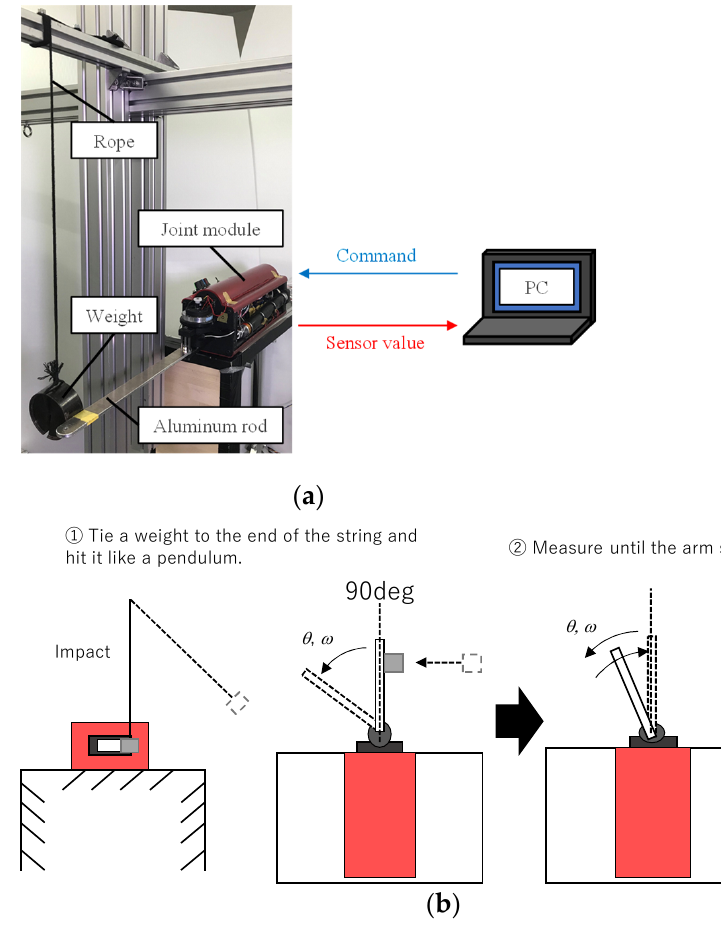
Figure 20. Diagram of the experimental environment for impact force experiment. ( a ). Actual experimental environment diagram. ( b ). Flowchart of experimental environment for impact force experiment.